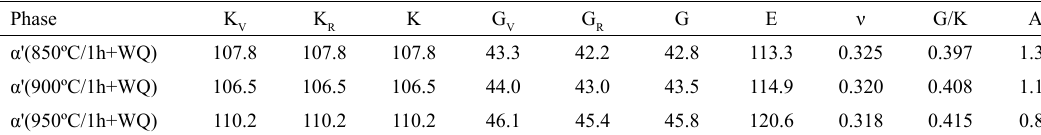
Table 4. Voigt ( index V ), Reuss ( index R ), and averaged macroscopic voigt-Reuss-Hill (VRH) modulus for the polycrystalline α' phase; all in Gpa except for ν ( dimensionless ), G/K and A G